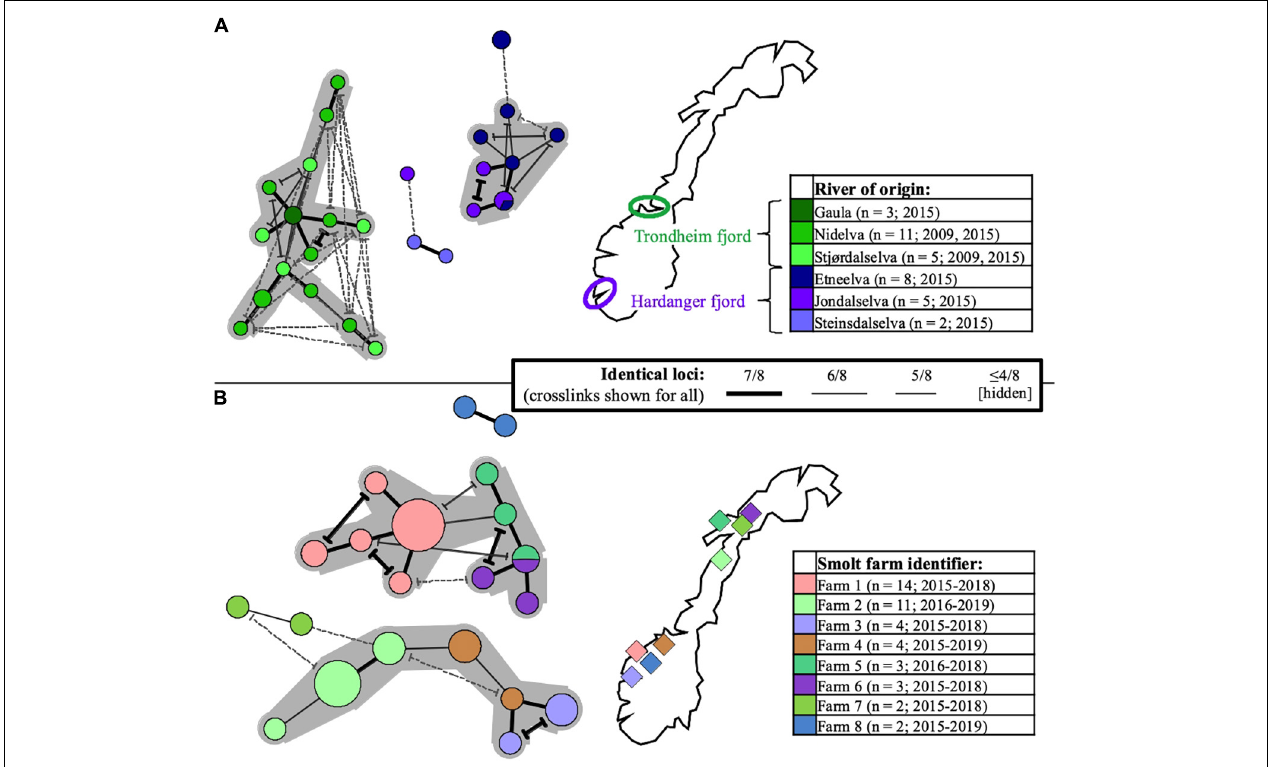
FIGURE 5 | Minimum-spanning-trees based on SGPV MLVA profiles, with branch representations indicated in the common centered legend (alternative branch connections, or crosslinks, have terminal demarcations). Coloring is with regard to river- or smolt farm of origin in Norway (for reference and further details, see Supplementary Table S1 ), as indicated in separate maps/legends in the respective panels (number of profiles and sampling time span also shown). Larger groups of profiles interconnected through ≥ 6/8 identical loci are highlighted with a gray background. Panel (A) shows the relationships between 34 SGPV specimens originating from wild Atlantic salmon (returning spawners), respectively in three rivers emptying into the Trondheim fjord (shades of green) and three rivers emptying into the Hardanger fjord (shades of purple). Panel (B) shows the relationships between 43 SGPV specimens originating from eight different freshwater farms for Atlantic salmon smolt. Unless heterogeneity was observed, only single samples from individual case submission were included for comparison.